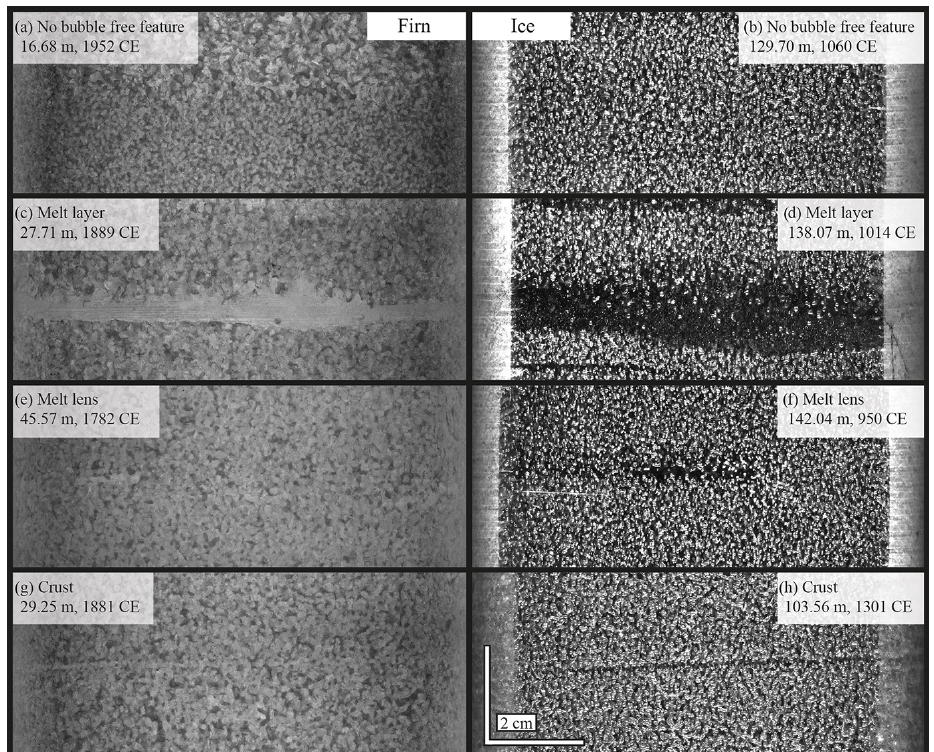
Figure 3. The appearance of different structures in line scan images of firn (left) and ice (right). (a, b) Typical examples of the appearance of firn and ice. (c, d) Bubble-free layers interpreted as melt layers. These are continuous horizontally across the ice core. (e, f) Bubble-free lenses interpreted as melt lenses, which are discontinuous patches that mostly have a horizontal elongation. (g, h) Very thin and straight bubble-free layers with sharp edges. These structures are hard to see in line scan images and are interpreted as crusts, the result of surface hardening by the